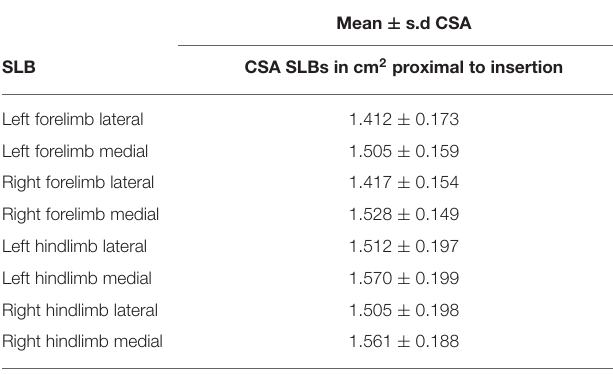
TABLE 3 | Mean cross-sectional areas (CSAs) of suspensory ligament branches (SLBS) in a population of elite level showjumping warmbloods with no recent history or current clinical signs of clinical SLB